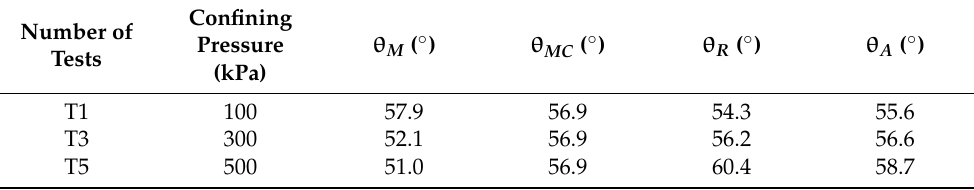
Table 4. Measured and calculated inclinations of shear